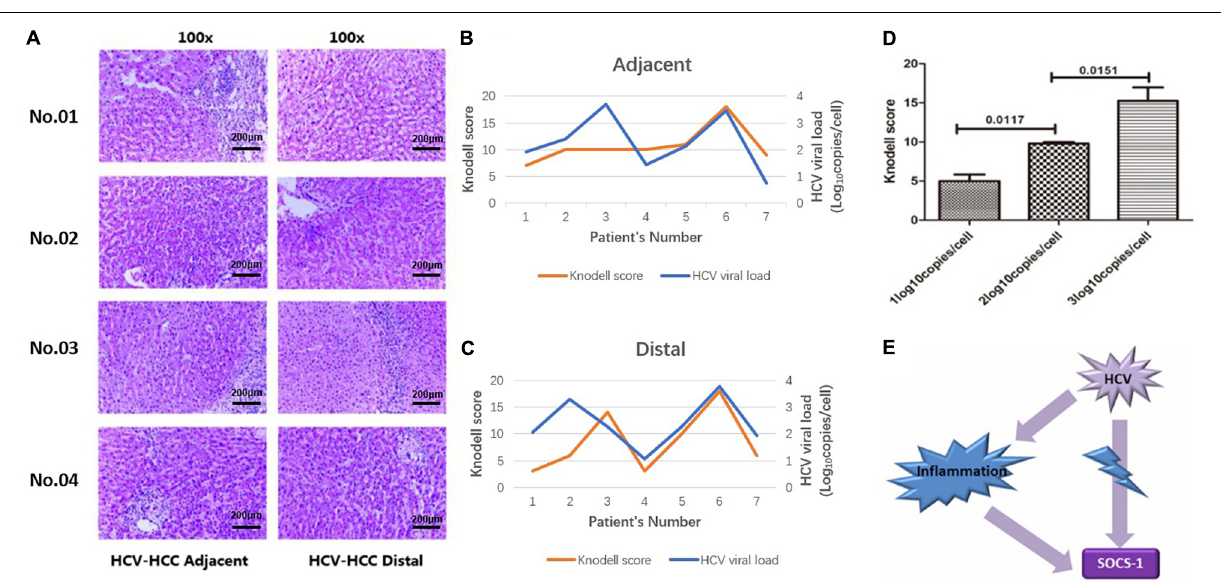
FIGURE 2 | Histological inflammation in non-HCC liver tissues with HCV infection (including adjacent and distal tissues). (A) Representative image of HE-stained non-HCC liver tissue with HCV infection (scale bar = 200 µ m). (B) The correlation between HCV viral load and Knodell scores in adjacent tissues of HCV-HCC. (C) The correlation between HCV viral load and Knodell scores in distal tissues of HCV-HCC. (D) Knodell scores in non-HCC tissues with different viral loads. Knodell score in tissues with a high viral load was higher compared to tissues with a low viral load. (E) Sketch map: Histological inflammation would induce expression of SOCS-1. HCV infection-induced inflammation may interfere with the correlation between HCV and SOCS-1 expression (Mann–Whitney U